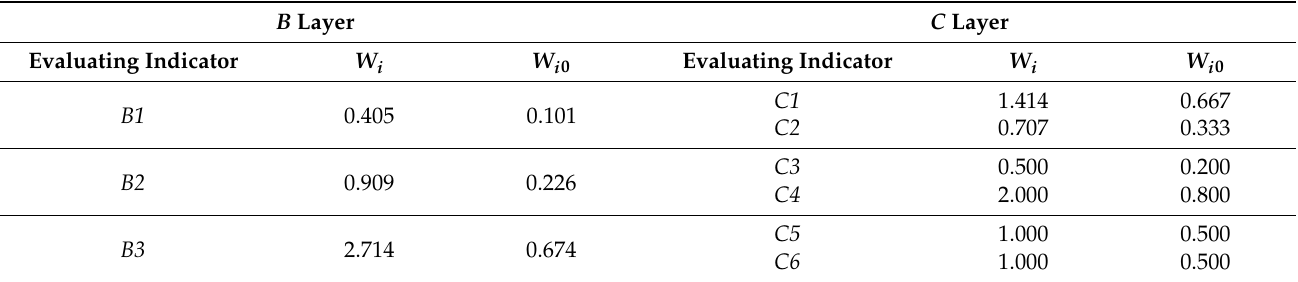
Table 3. Relative weight calculation results.